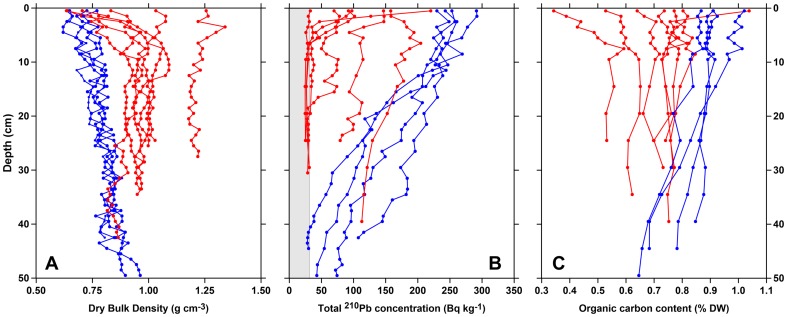
Contrasting sediment properties at trawled and untrawled areas.From left to right, vertical profiles of: dry bulk density (A); total 210Pb concentration (B) and organic carbon content (C), in sediment cores collected at the flanks of La Fonera Canyon, grouped according to their position in fishing grounds (red) or control (untrawled) areas (blue). The profile with the highest densities corresponds to core NF-5 from the distal part of the north canyon flank. The shadowed area in the central panel represents supported (in equilibrium with 226Ra) 210Pb. Concentration values in excess of that threshold indicate net accumulation of recently (within the order of a century) deposited sediments, while 210Pb concentrations within the threshold indicate sediments older than 100–150 years. Horizontal error bars in 210Pb data are 1-sigma. For the sake of clarity, an isolated value of organic carbon of 1.9% at 4 cm for core SF-1 has been omitted.